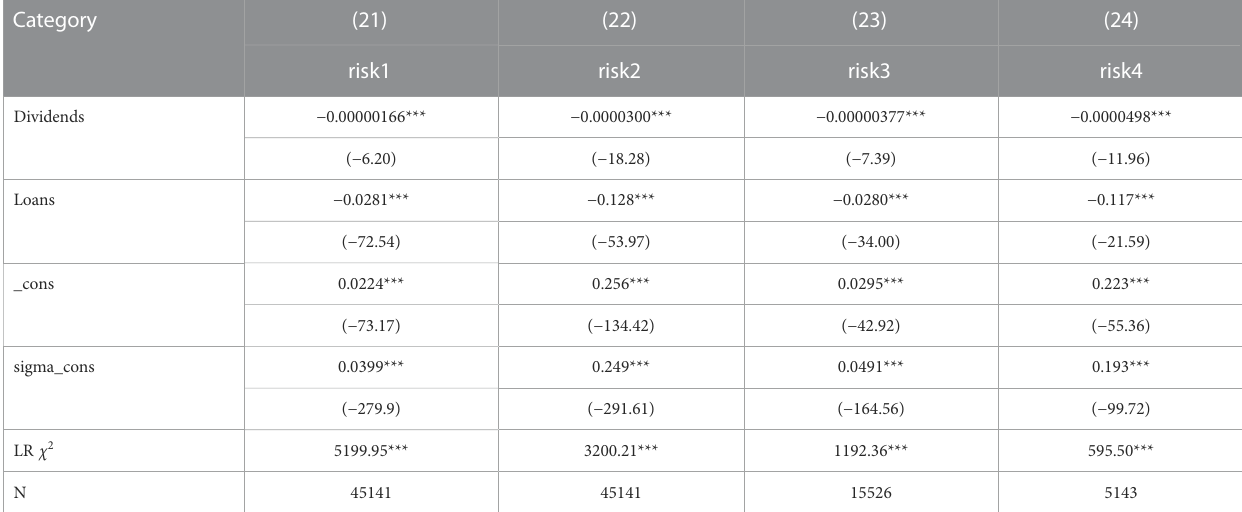
TABLE 9 Tobit regression estimates of fi nancial capital variables to re-poverty risk.